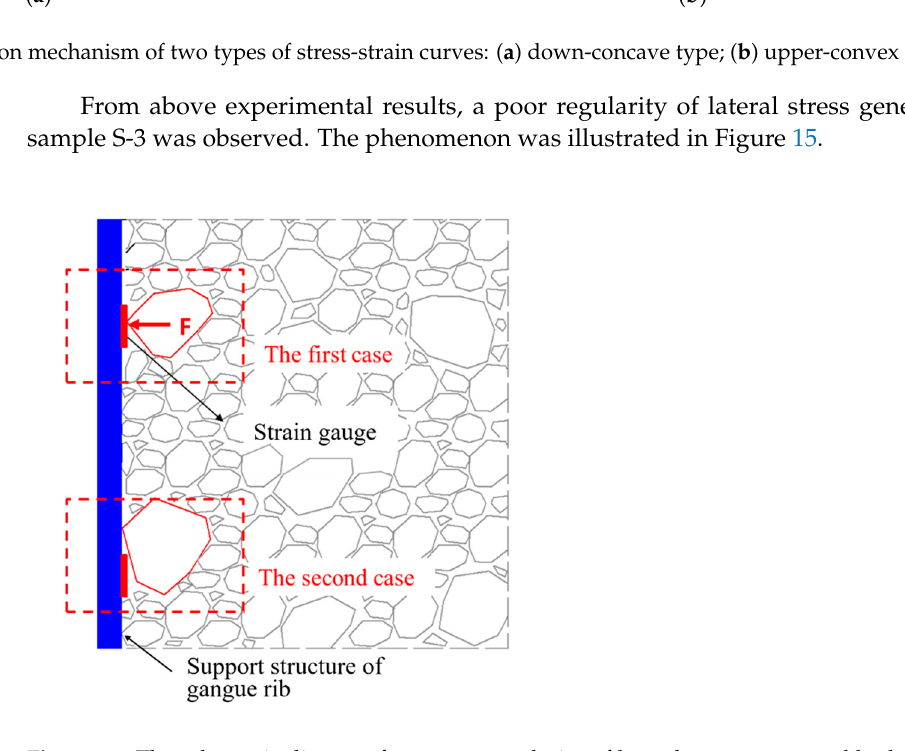
Figure 15. The schematic diagram for a poor regularity of lateral stress generated by larger-sized crushed rocks. crushed